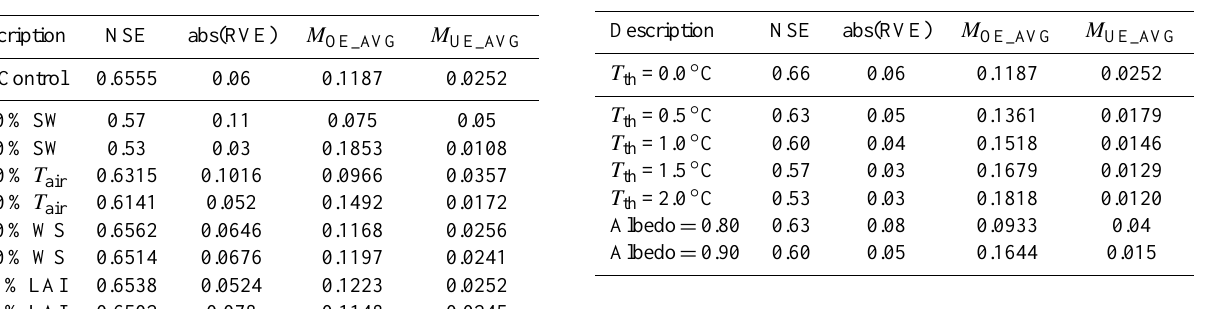
Table 8. Model sensitivity to uncertainty in precipitation phase (threshold air temperature) and albedo in visible spectrum,